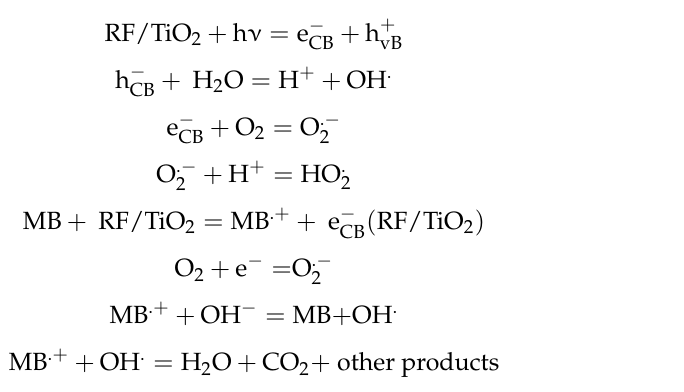
Figure 12. ( a ) Photocatalytic performance regarding MB dye degradation without catalyst, and with pristine RF, pristine TiO 2 and RF/TiO 2 gel ( b ) First-order kinetics of photoactivity without catalyst, and with pristine RF, pristine TiO 2 , and RF/TiO 2 gel .